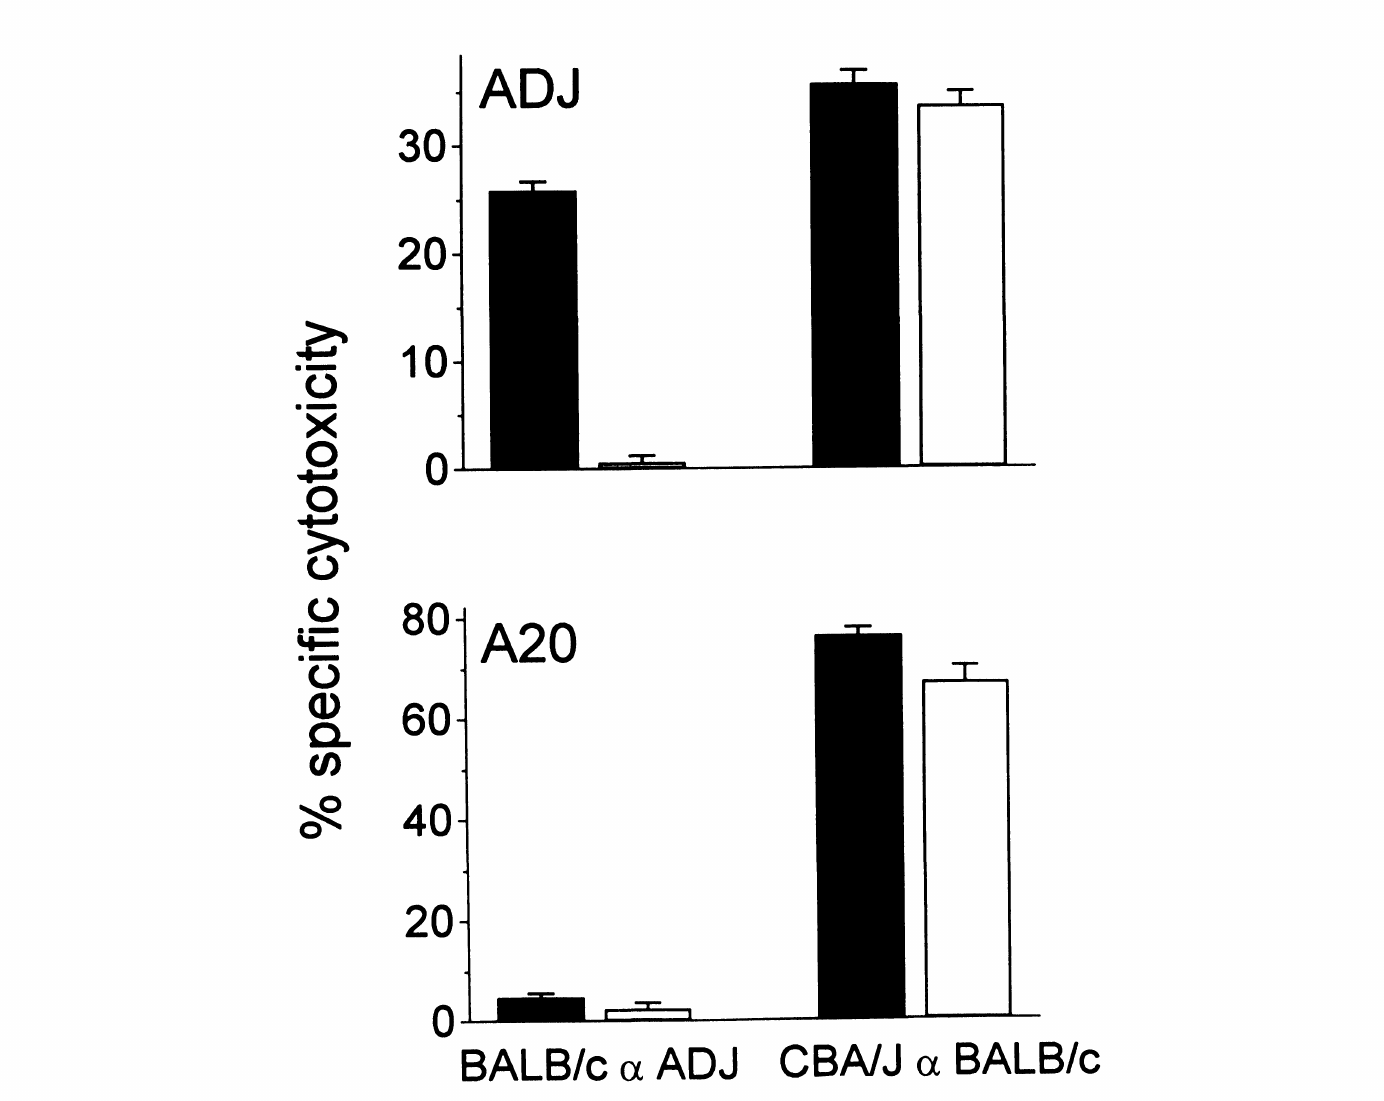
FIGURE 2 Induction of ADJ-PC-5-specific Tc cells in a primary MLTC depends on tumor-derived IL-10. MLTC cultures (BALB/c ce ADJ) were set up with 2 107 BALB/c spleen cells and 106 X-irradiated ADJ-PC-5 cells in the absence (closed bars) or presence (open bars) of a mix of two IL-10-specific monoclonal antibodies (SXC-1 and SXC-2; 10/xg/ml each). Allogenic MLC cultures (CBA/J ce BALB/c) were set up in the presence or absence of IL-10-specific antibodies with 2 107 CBA/J spleen cells and 107 X-irradiated BALB/c spleen cells. The resulting cytotoxicity was measured on day 6 against ADJ-PC-5 (ADJ) cells and a syngeneic control B-cell tumor